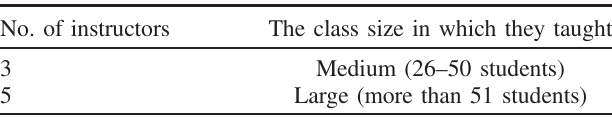
TABLE X. The size of the classes taught by the focus group participants ( N ¼ 8